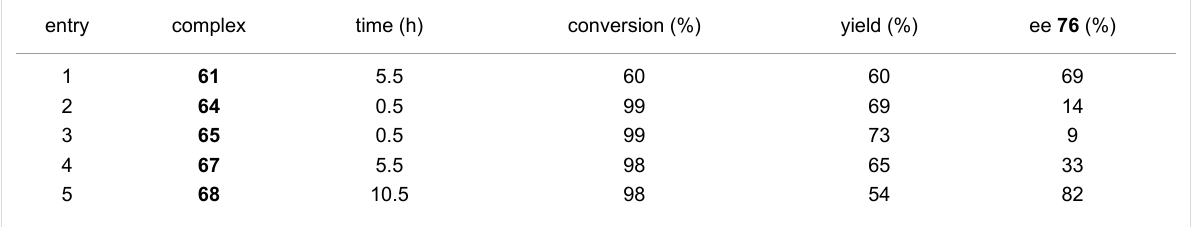
Table 3: AROCM of cis -5-norbornene- endo -2,3-dicarboxylic anhydride ( 75 ) with catalysts 61 , 64 , 65 , 67 and 68 .